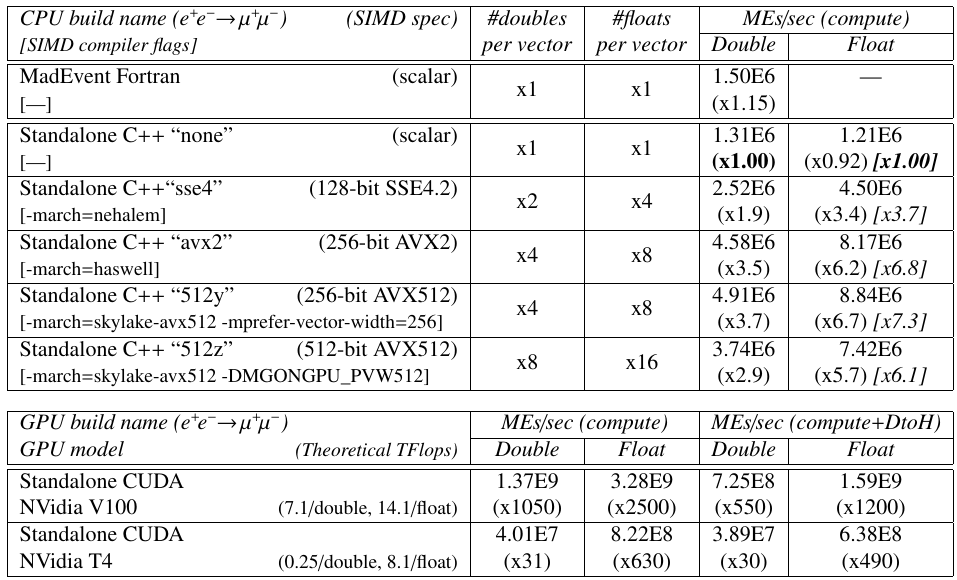
µ + µ − , in Fortran, C ++ and →